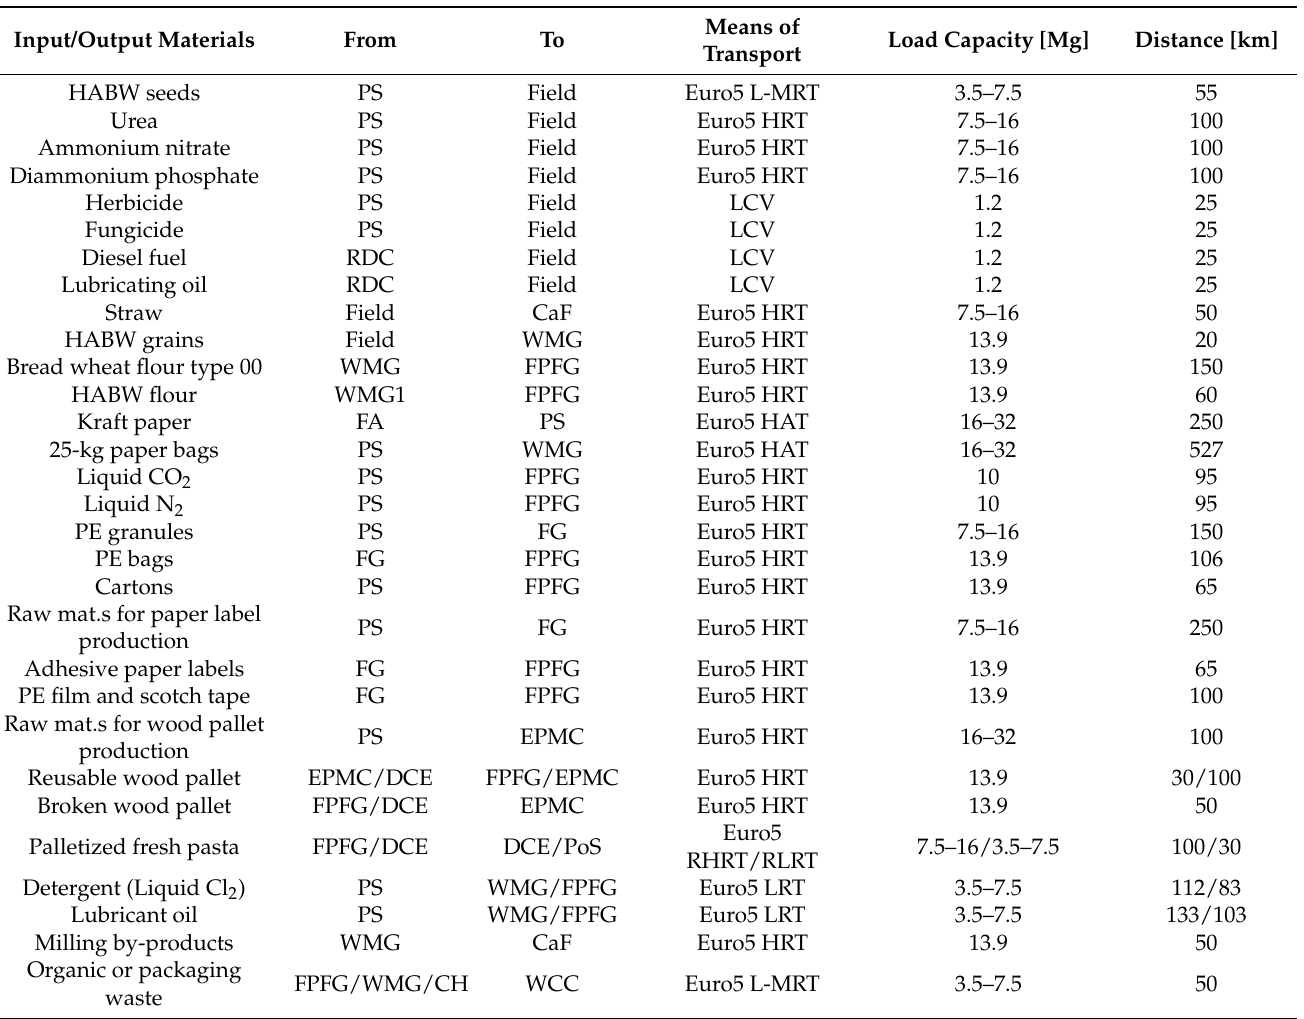
Table 4. Logistics of input/output materials with indication of the means of transport used and distance travelled from different production sites to destination ones. All symbols were listed in the Nomenclature